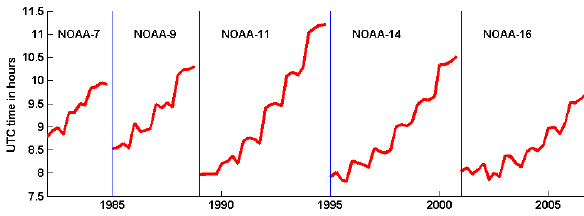
Fig. 1. Monthly mean time of observation (in UTC) averaged over the entire study area for the ascending passes (i.e. daytime data only) for different NOAA satellites for the JJAS months.